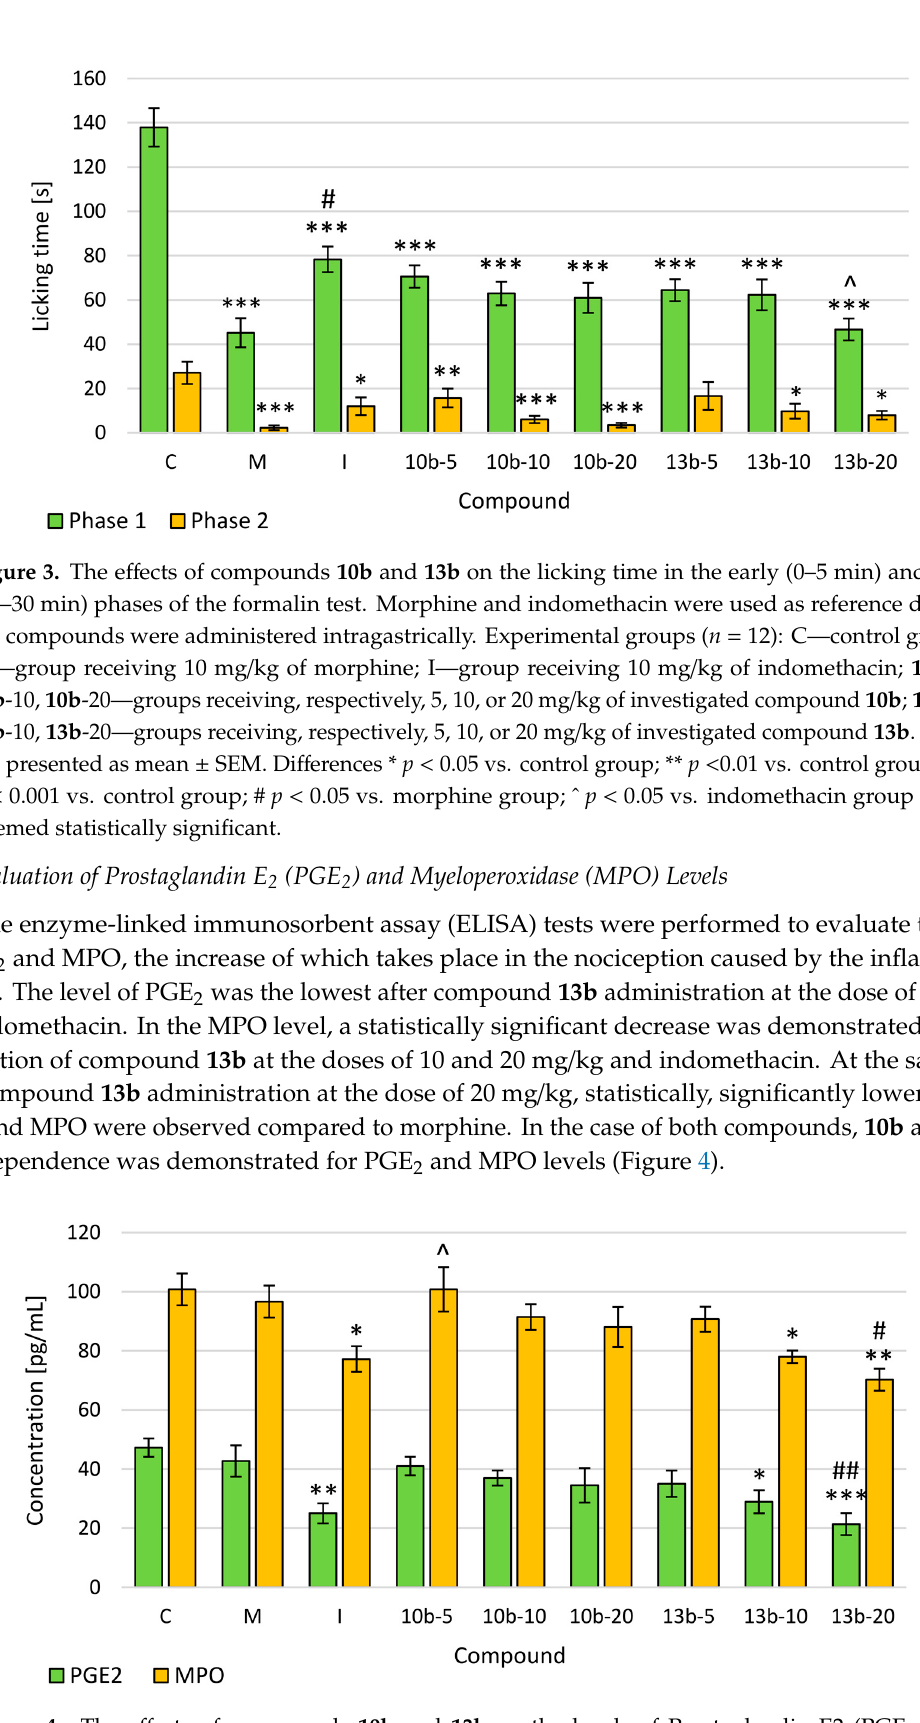
Figure 4. The effects of compounds 10b and 13b on the levels of Prostaglandin E2 (PGE 2) and Myeloperoxidase (MPO) in mice serum. Blood samples were collected before mice were sacrificed.